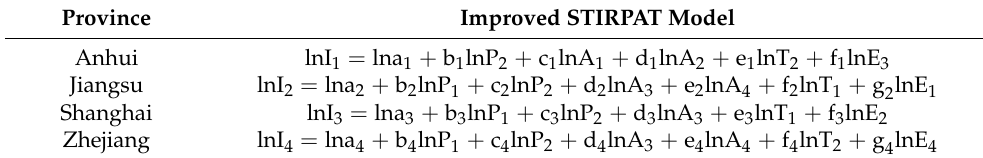
Table 3. Improved STIRPAT Model of four provinces.